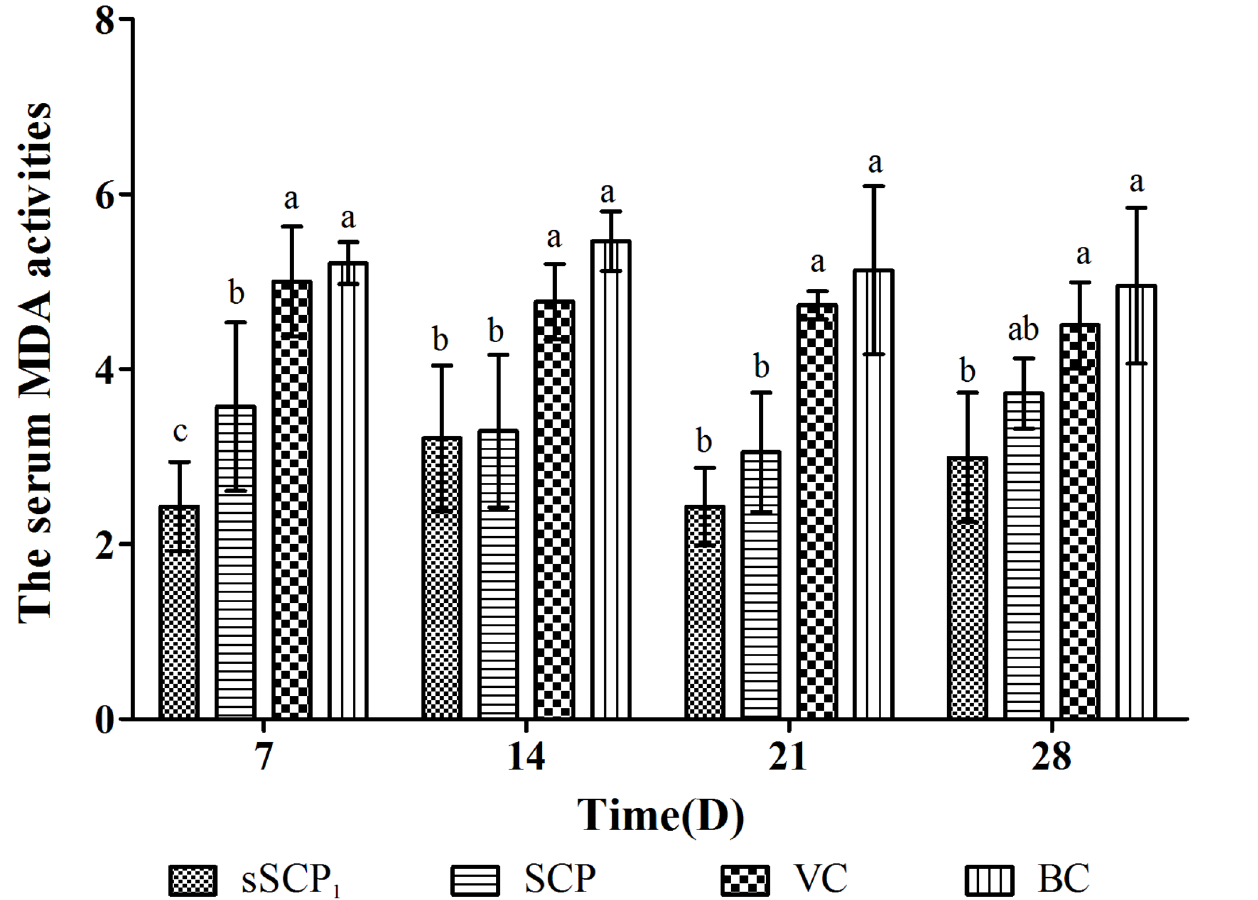
Fig 10. The serum MDA activities in each group. Bars in same time without the same superscripts (a – c) differ significantly ( P < 0.05).